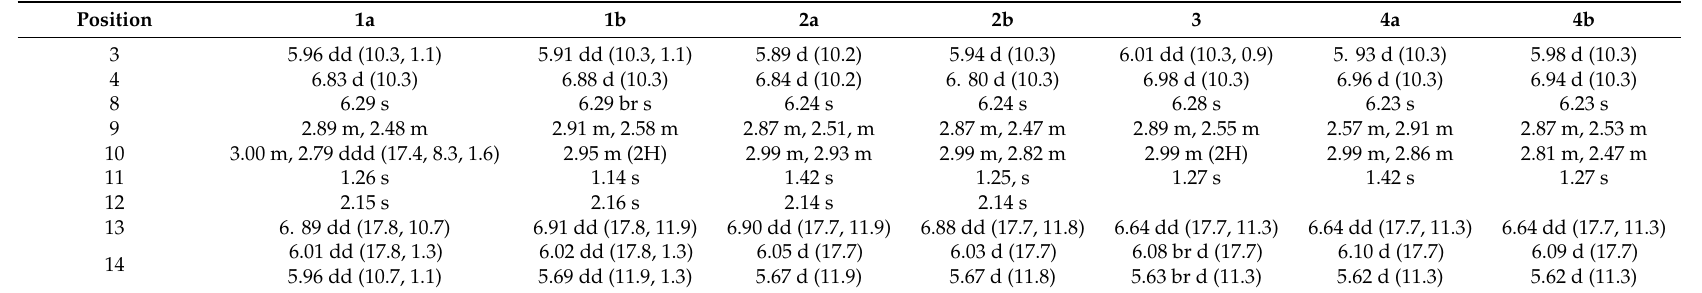
Table 1. 1 H-NMRspectroscopic data for compounds 1 – 4 (500 MHz, CDCl 3 , δ ppm, and J in